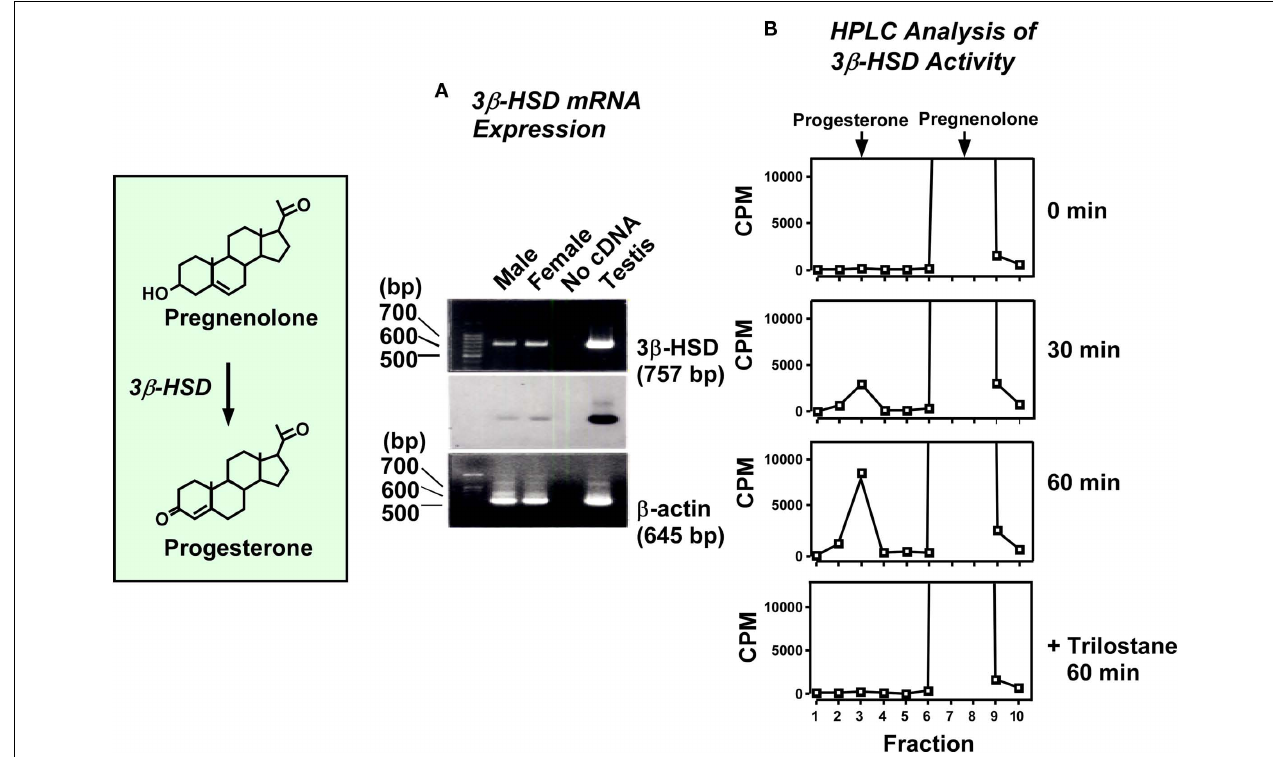
control. (B) HPLC analysis of neurosteroids extracted from quail brain slices after different incubation times with 3 H-pregnenolone using a reversed-phase column.The column was eluted with a linear gradient of 40–70% acetonitrile. The ordinate indicates the radioactivity measured in each HPLC fraction.The arrows indicate the elution positions of pregnenolone and progesterone.The brain slices were also incubated with trilostane, a specific inhibitor of 3 β -HSD, for 60min and subjected to HPLC analysis. See Ukena et al. (1999a) for